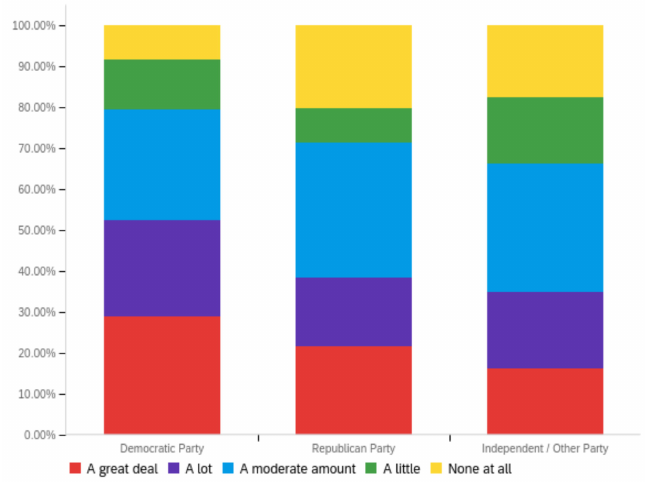
Figure 6. Article sponsor—ideal perception impact by political